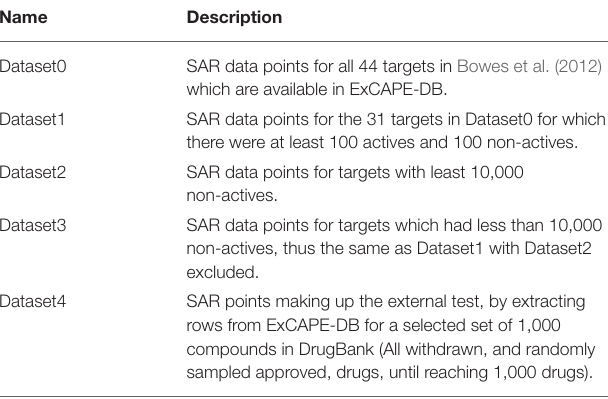
TABLE 2 | Summary of datasets